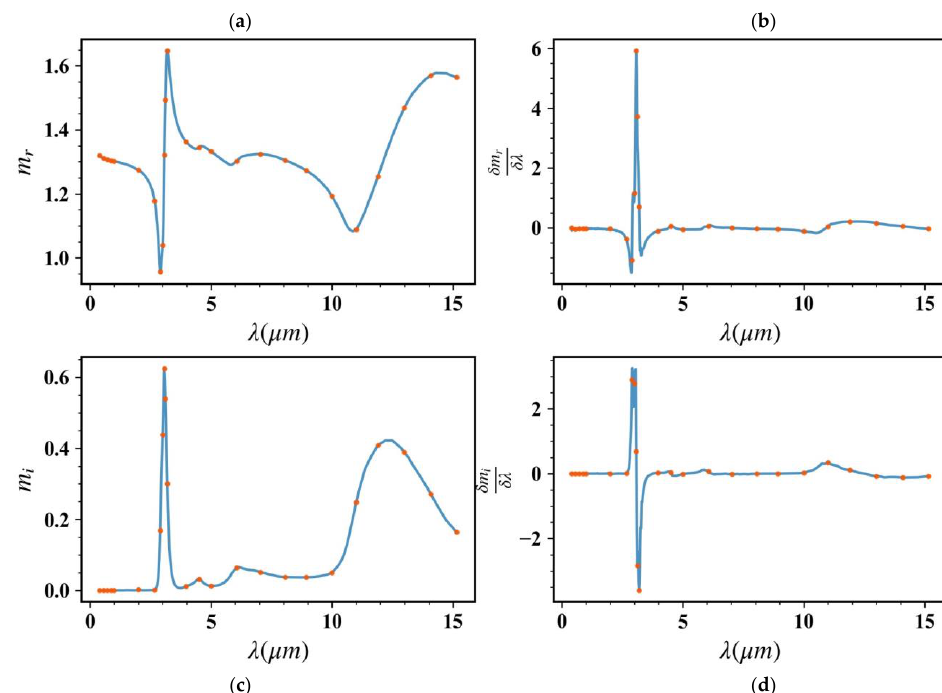
Figure 1. Trends in the complex refractive index and their changing rates of ice, ( a , b ) for the real parts ( m r ) and ( c , d ) for the imaginary parts ( m i ). δ is the differential notation. Data are from Warren et al. (2008) [59] . Points represent the wavelengths selected in this database.